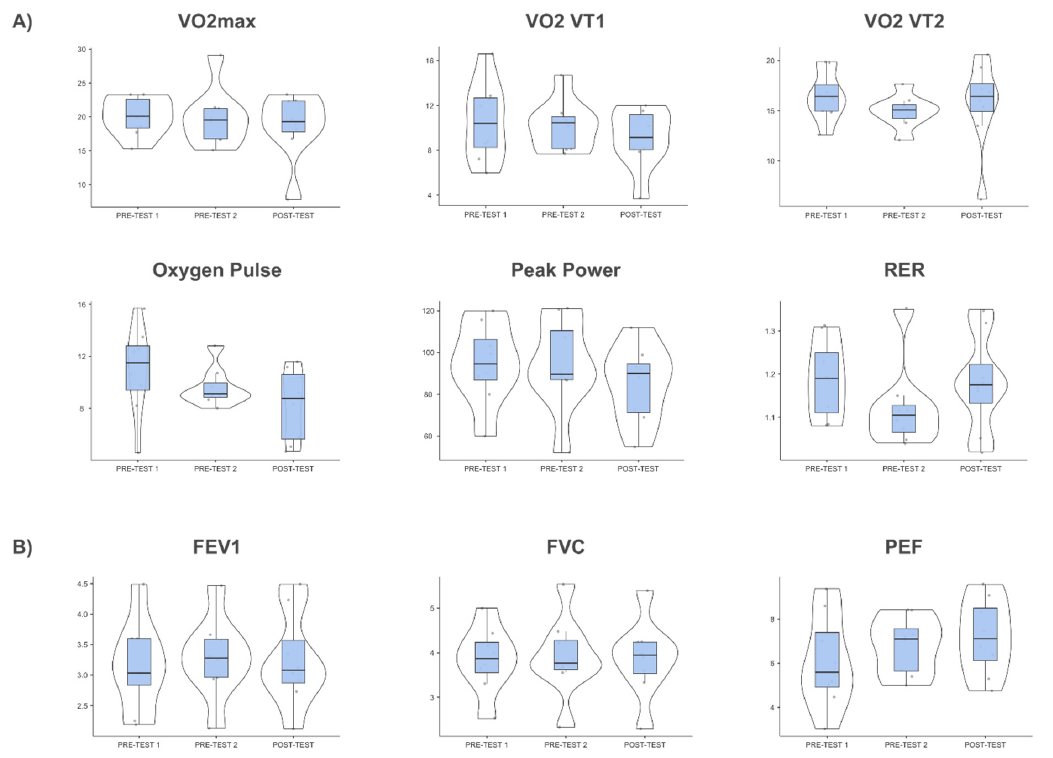
Figure 2. Box plots of cardiopulmonary exercise test ( A ) and spirometry ( B ) scores at the three